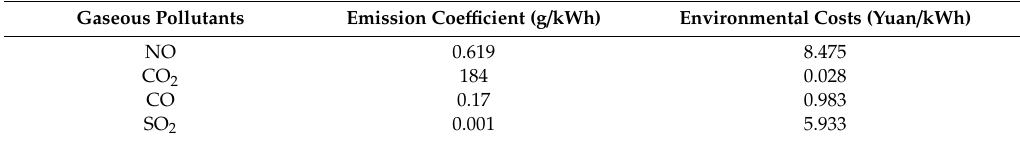
Table 11. Emission coe ffi cients of gaseous pollutants and corresponding environmental costs.